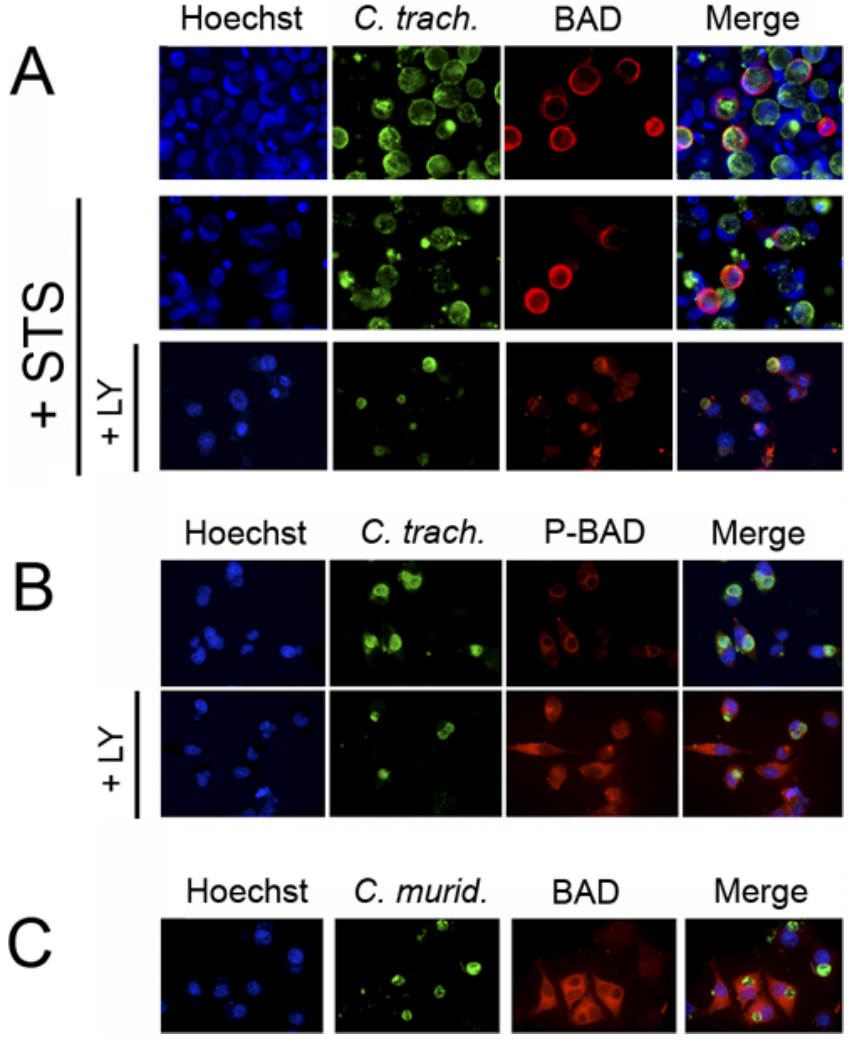
Figure 7. Localization of BAD and Phosphorylated BAD in Cells Infected with C. trachomatis or C. muridarum (A) In order to visualize BAD by immunofluorescence, epithelial cells were transfected with the BAD expression plasmid prior to infection. Cells over- expressing BAD were infected with C. trachomatis for 26 h and then incubated with 50 l M LY294002 (LY) or control buffer for 6 h before treating with 2 l M STS or control buffer overnight. BAD is localized to the surface of Chlamydia vacuoles in infected cells, with or without STS treatment (first and second rows). The co-localization of BAD and Chlamydia vacuoles is lost in STS-treated infected cells that had been pre-incubated with LY294002 (bottom row). (B) Cells over-expressing BAD were infected with C. trachomatis for 15 h and then incubated with control buffer (top row) or 50 l M LY294002 (LY) (bottom row) for 6 h. Phosphorylated BAD is concentrated around the early Chlamydia vacuoles, but has a cytosolic distribution in infected cells after treatment with LY294002. Cells treated with LY294002 were exposed at a longer time in order to visualize background phosphorylated-BAD staining. (C) Cells over-expressing BAD were infected with C. muridarum for 15 h. BAD has a cytosolic distribution in infected cells, even in the absence of LY294002. DNA was revealed with Hoechst (blue), Chlamydia with FITC-conjugated anti- Chlamydia antibody (green), and BAD with Texas Red- conjugated anti-BAD antibody or phosphorylated BAD with Texas Red-conjugated antibody recognizing BAD phosphorylated on residue Ser 136 (red). In each case, one experiment of two representative experiments performed on separate days is shown. DOI: 10.1371/journal.ppat.0020045.g007